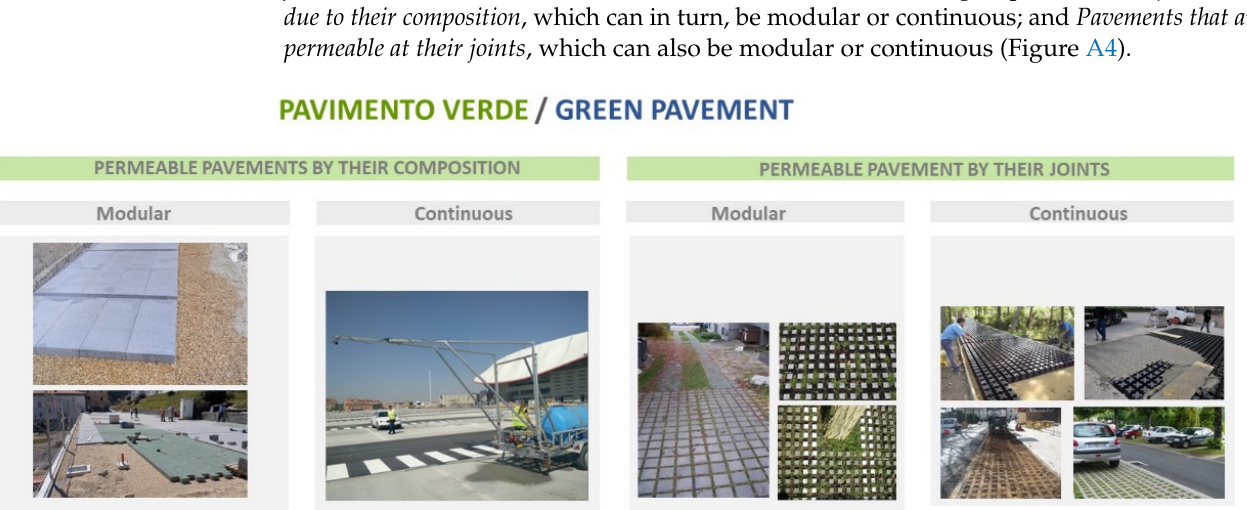
Figure A4. Types of green pavement (table and images by the authors, except images of continuous pavements [65,66]).